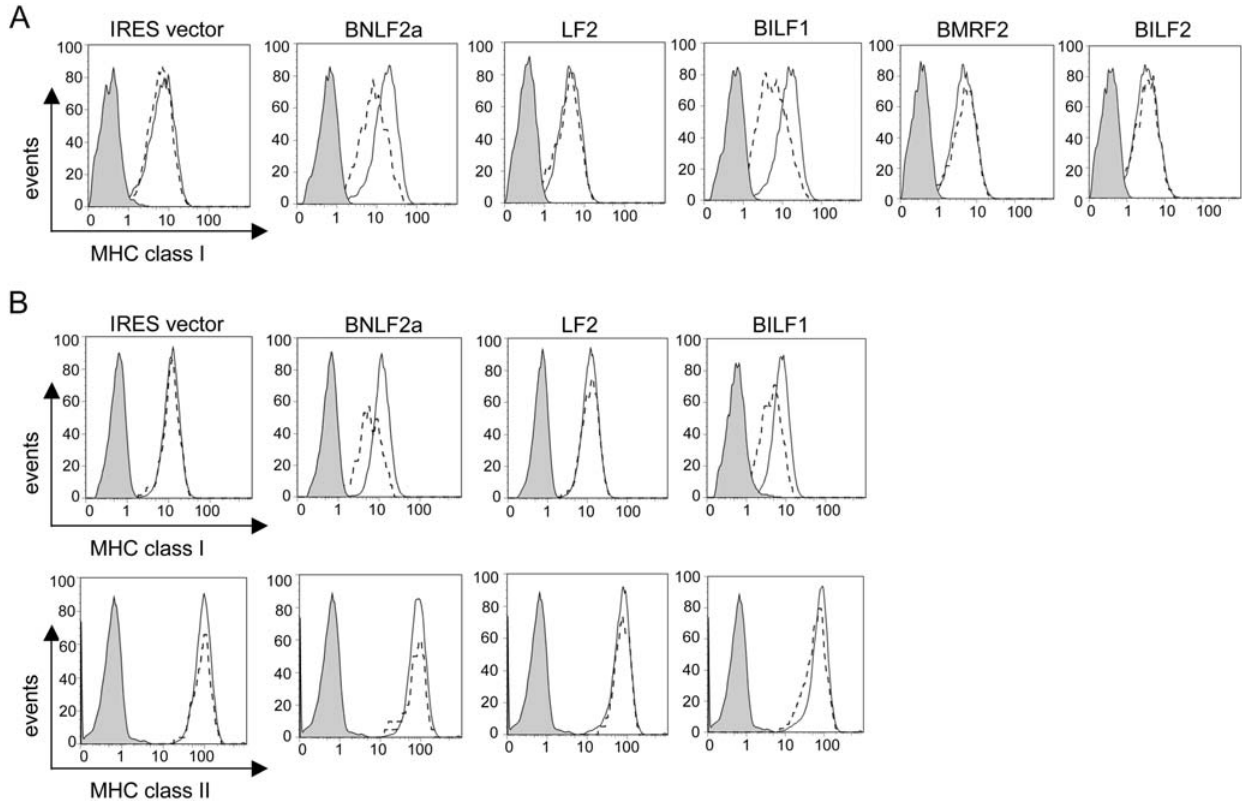
Figure 1. BILF1 identified as a lytic gene that downregulates surface MHC class I. 293 ( A ) or MJS ( B ) cells were transfected with different EBV genes in the bi-cistronic vector, pCDNA3-IRES-nlsGFP. At 48 hr post-transfection, surface MHC class I was stained with PE-conjugated W6/32 mAb and (in MJS only) MHC class II was stained with PE-conjugated anti-DR mAb, YE2/36-HLK. Two-colour flow cytometry was used to analyse staining in the untransfected GFP 2 population, shown as the solid line histogram, and in the transfected GFP + population, shown as the dashed line histogram. The grey histogram denotes background staining obtained with an isotype control PE-conjugated antibody.